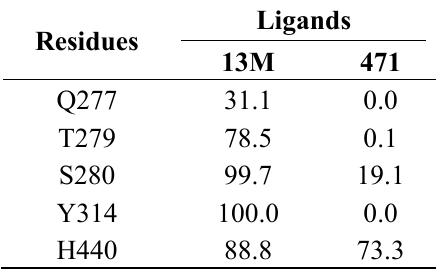
Table 1. The probability (%) of hydrogen bonds between PPAR-α and ligands.